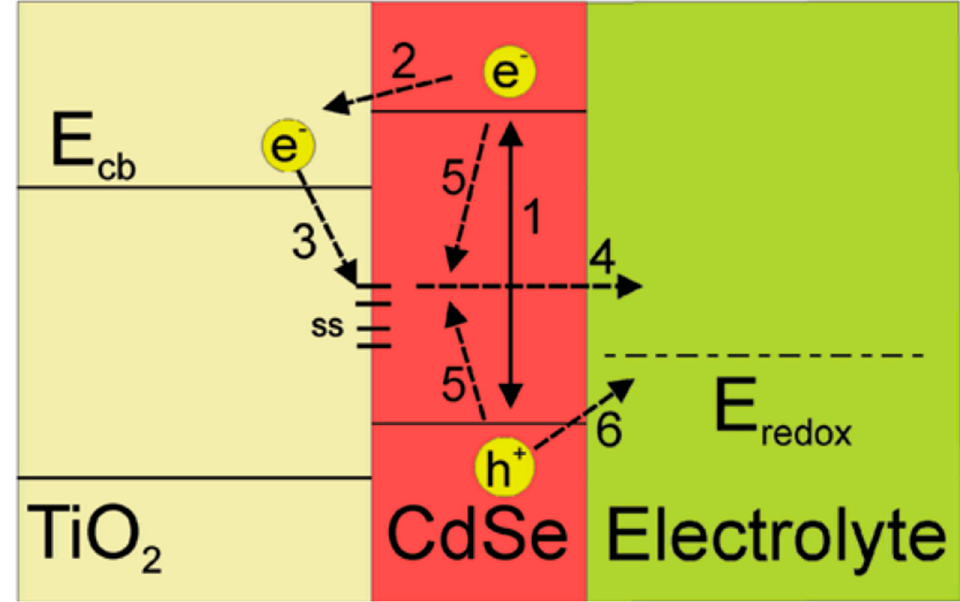
Figure 3. Schematic of the energy levels of different material layers and main processes in an operating QDSSC: (1) exciton generation in CdSe QDs, (2) electrons transferring from CdSe QDs into TiO 2 layer, (3) electron trapping causing by QDs’ surface trap states, (4) electrons diffusion from CdSe QDs into electrolyte, (5) relaxation in CdSe QDs, and (6) recombination of electrons in electrolyte and holes in CdSe QDs by reduction reaction at the QDs/electrolyte interface. It was obtained from Mora-Sero and co-works, 2009 [79].